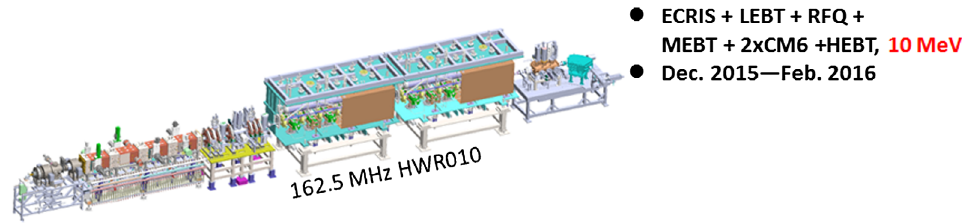
FIG. 4. Mechanic drawing of the injector scheme